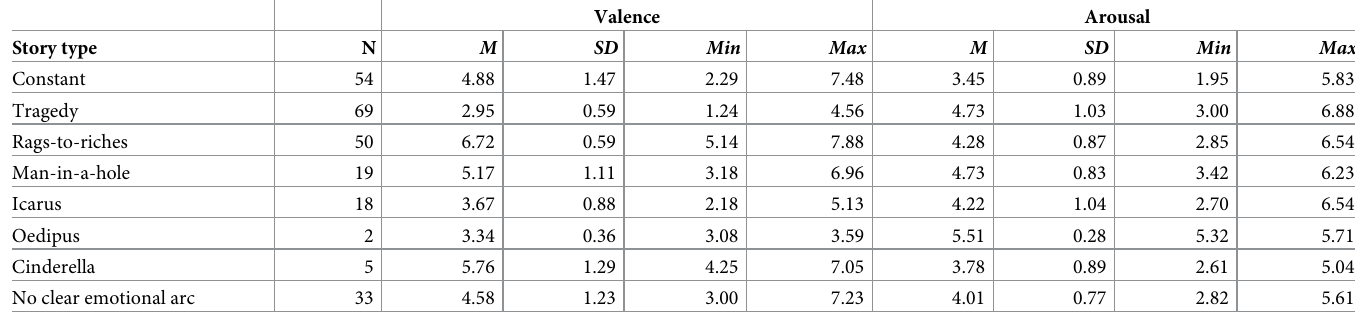
Table 7. Means, standard deviations, minimum and maximum values of valence and arousal ratings of texts as a function of story type.